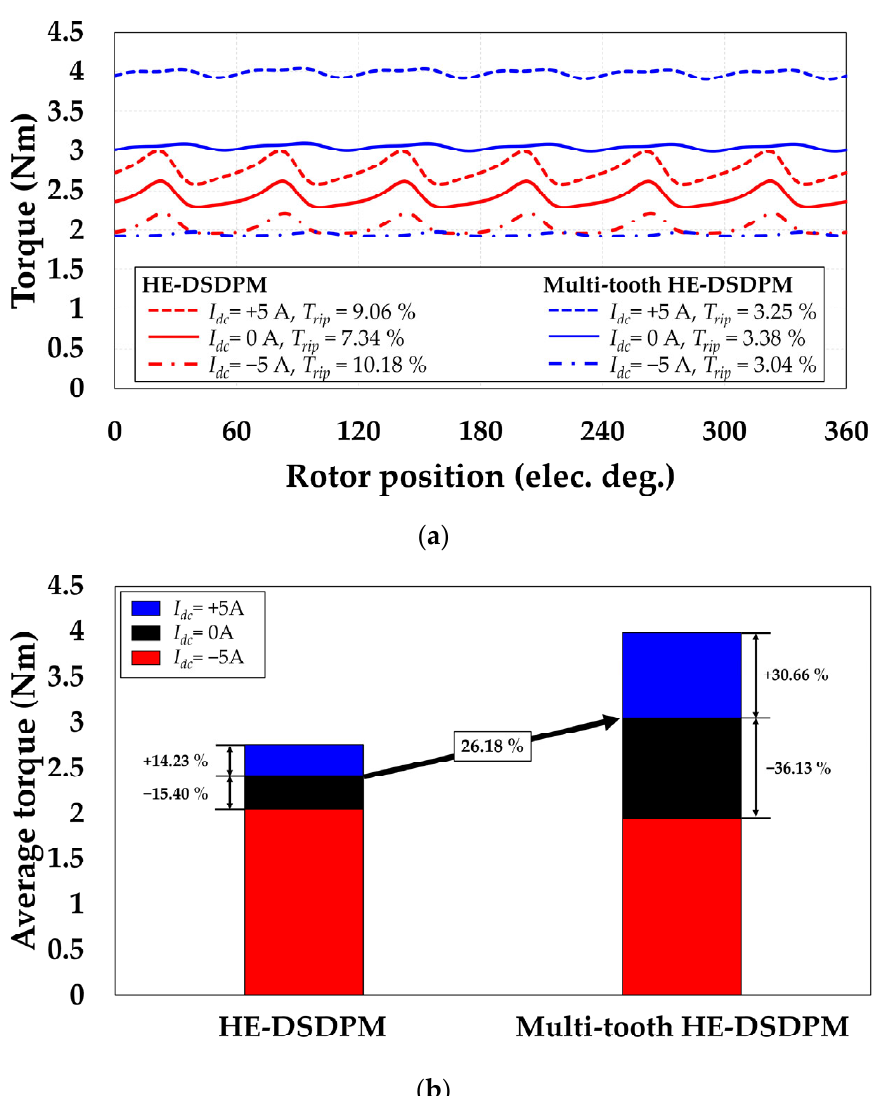
Figure 10. Electromagnetic torque of the proposed HE-DSDPM with various I dc : ( a ) waveform and ( b ) average.